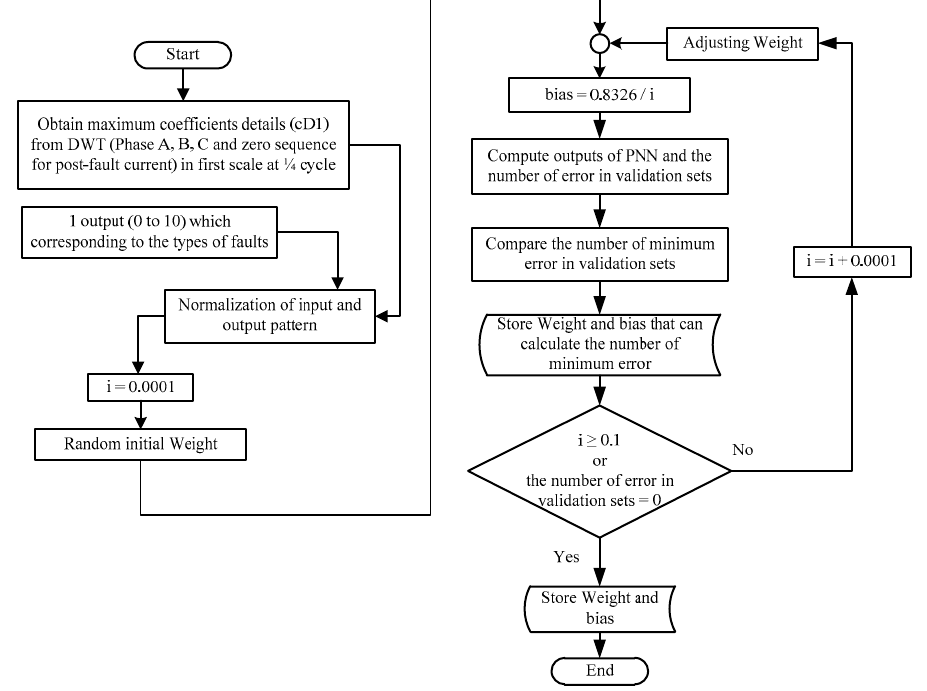
Figure 5. Training process of the probabilistic neural network (PNN).